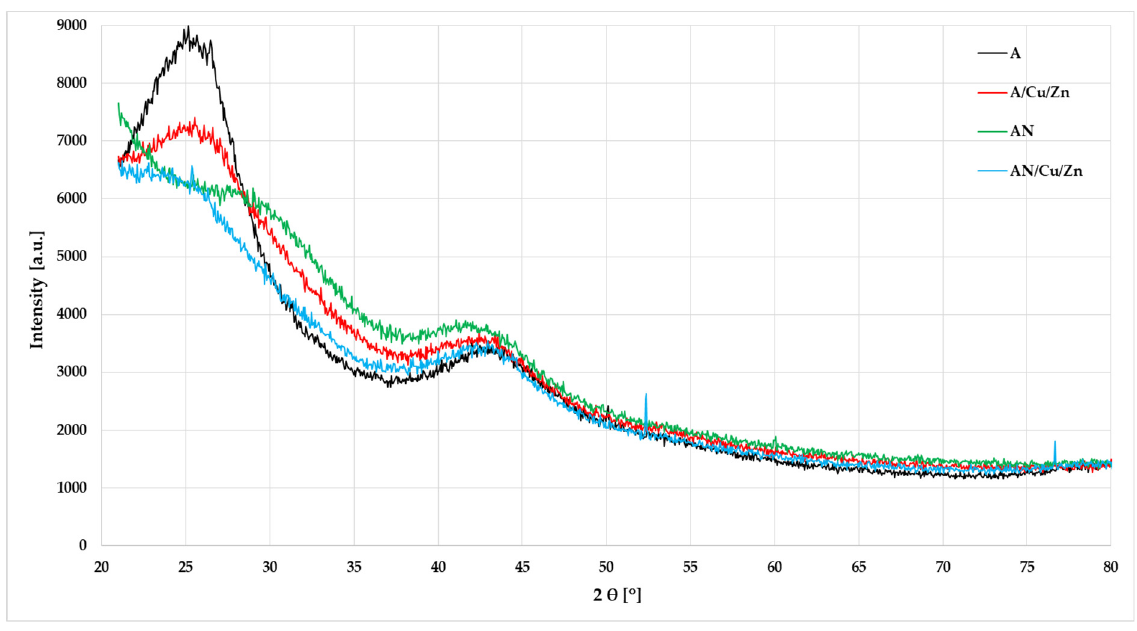
Figure 6. The XRD patterns of the activated carbons before and after Cu(II) and Zn(II) ions’ adsorption (pH: 6, heavy metal ions’ concentration: 10 mg/L, mass of adsorbent: 0.01 g, time 240 min, shaking speed 180 rpm).